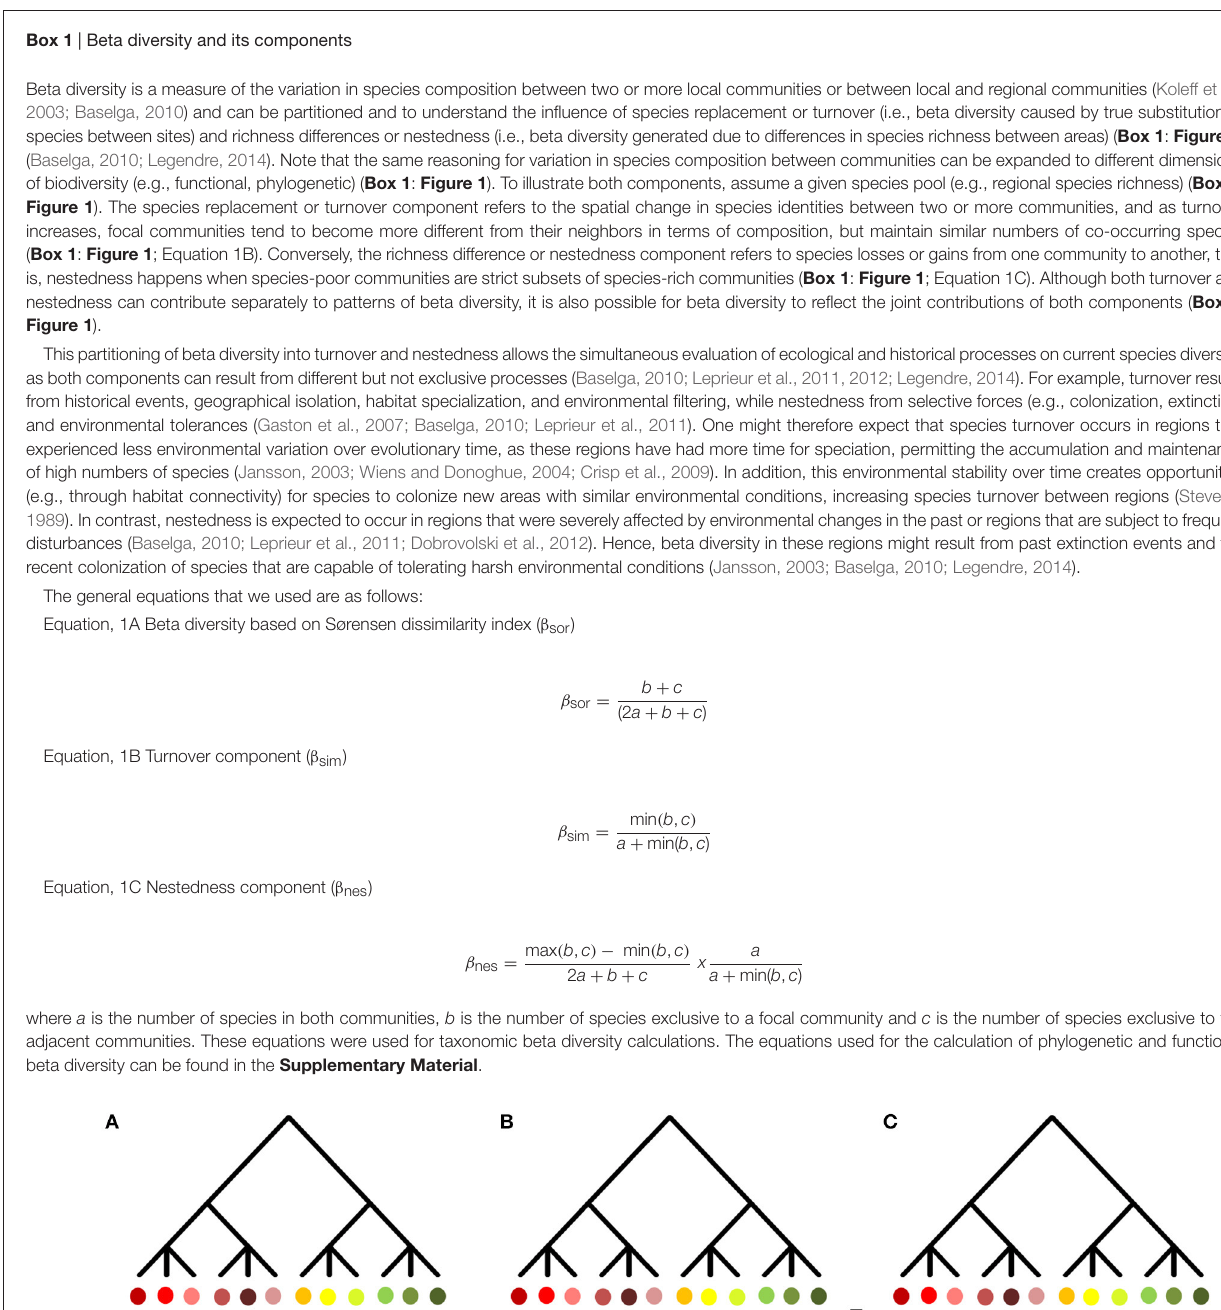
Frontiers in Ecology and Evolution |